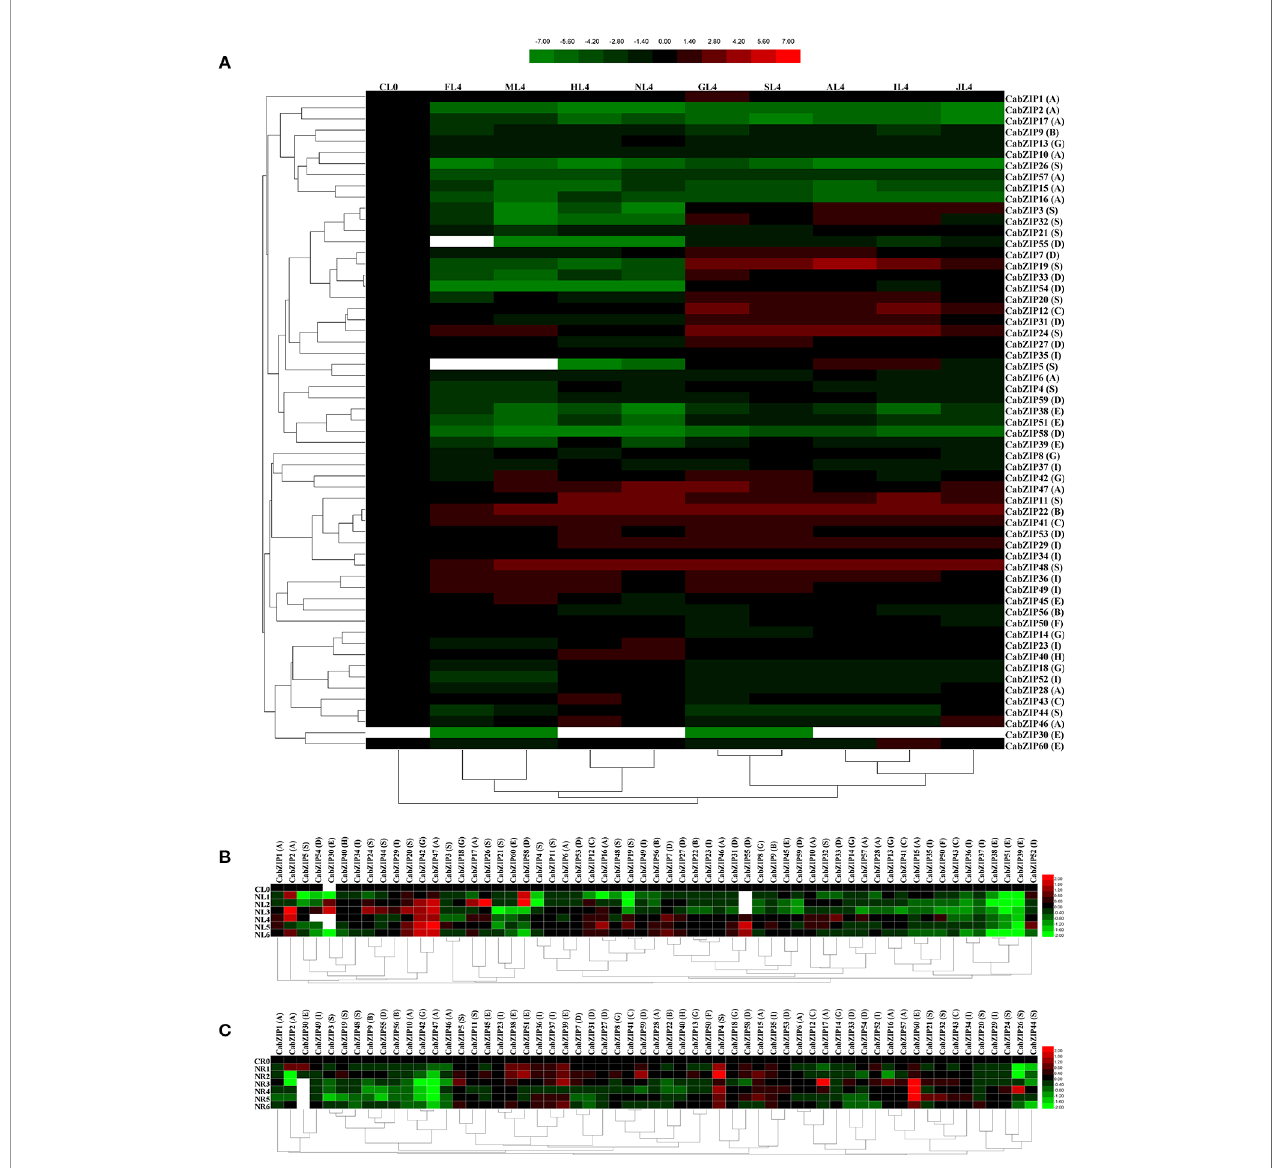
FIGURE 4 | Patterns of 59 CabZIP genes differentially expressed during abiotic stress and phytohormone treatments. (A) Expression patterns of CabZIP genes in leaf at 6 h post treatment. CL0, FL4, ML4, HL4, NL4, GL4, SL4, AL4, IL4, and JL4 represents the control, cold, mannitol, heat, salt, GA3, SA, ABA, IAA, and JA treatment, respectively. (B , C) Expression patterns of CabZIP genes in leaf (B) or root (C) under salt stress. CL0/CR0, NL1/NR1, NL2/NR2, NL3/NR3, NL4/NR4, NL5/NR5, and NL6/NR6 represents the expression levels of CabZIP genes in leaf/root at 0, 0.5, 1, 3, 6, 12, and 24 h post treatment, respectively. Log2 (treated/ control) ratio values represents the fold change of the gene expression. The color scale is shown at the top (A) or right (B , C) . Green indicates low expression values; black indicates intermediate expression values and red indicates high expression values. The empty values were indicated as white. Group numbers are labeled after each gene name. See Supplementary Table S5 for detailed transcriptome